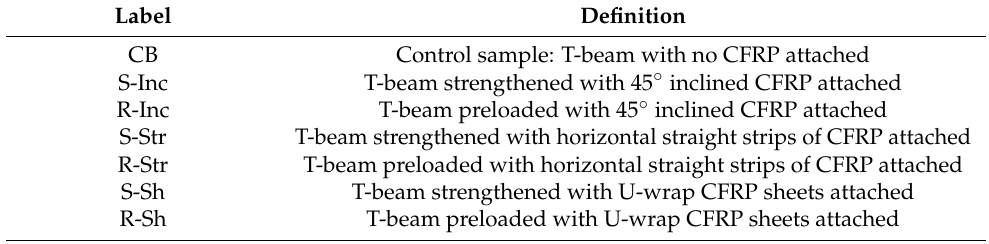
Table 7. Test specimen notations.